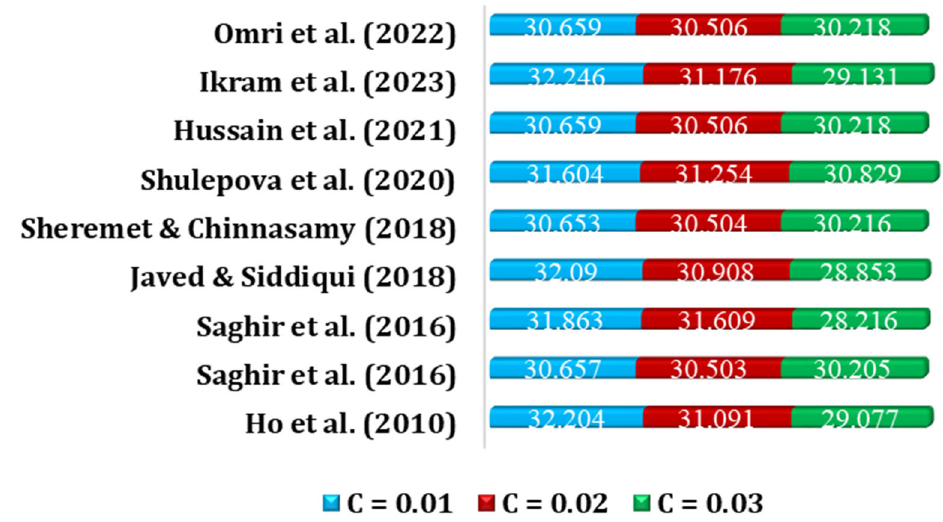
Figure 8. Variation of Nu for Ra = 10 3 (Case: Porous square cavity) [20,285–288].